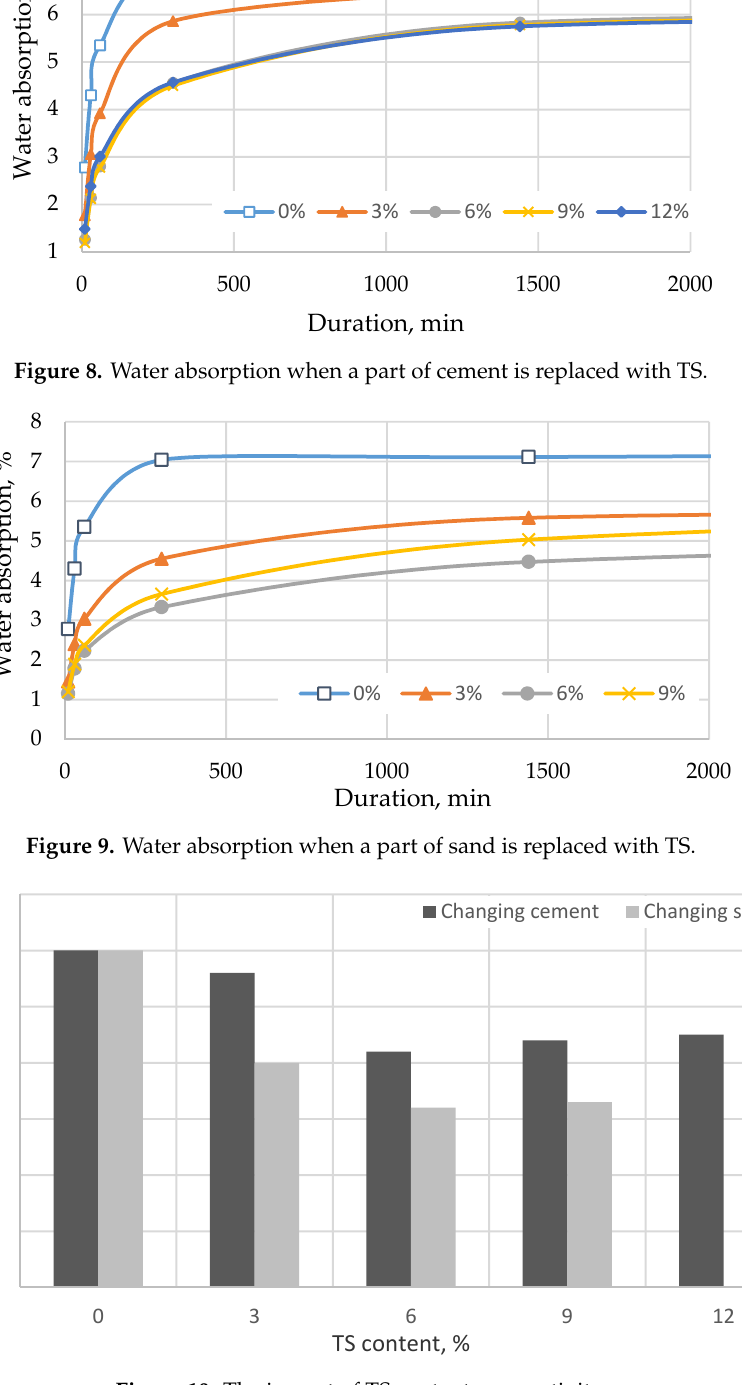
Figure 11. The impact of TS on the sorptivity in mortars used for renovation application. The values of sorptivity presented in Figure 10 were determined for ordinary mortars when the results were recorded 10 and 90 min after the specimens had been saturated with water due to capillary action. The average standard deviation of all batches was 0.01 kg/m 2 min 0.5 . Values of sorptivity presented in Figure 11 were determined by measuring the initial mass of the specimen and the mass after saturation due to capillary action after 24 h. The average standard deviation of all batches was 0.14 kg/m 2 . The results obtained in both tests were very similar. The lowest sorptivity was obtained in mortars containing 6% of TS. Sorptivity in specimens where 6% of the cement was replaced with TS reduced by ~30%, as compared to the reference specimen and in specimens where 6% of the sand was replaced with TS, sorptivity reduced by 50%. Besides, those specimens containing 6% of TS had the lowest surface porosity. It can be explained by the optimal amount of TS and the water amount used. TS has a rather large specific surface area through which water required for cement hydration is easily absorbed. Fine TS particles saturated with water fill in the voids between cement particles and thus promote a faster release of water to C 3 S crystals where C-S-H formation starts. A cement matrix with a dense structure is formed. When the TS amount in the mix is increased, there is not enough water to wet TS particles and thus cement binding decelerates and the porosity of the mortar increases. The best results were obtained with specimens in which 6% of the sand was replaced with TS; therefore, SEM analysis of these specimens and reference specimens was performed. The SEM images are presented in Figure 12.